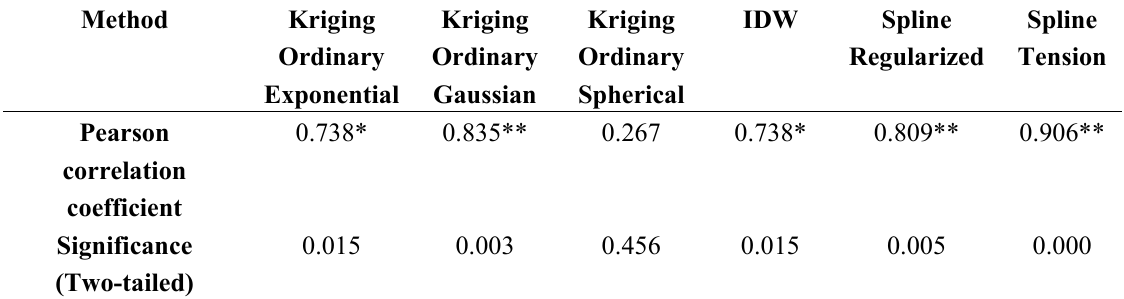
Table 2. Pearson correlation coefficient and statistical significance between the observed and predicted soil available phosphorus values using different interpolation